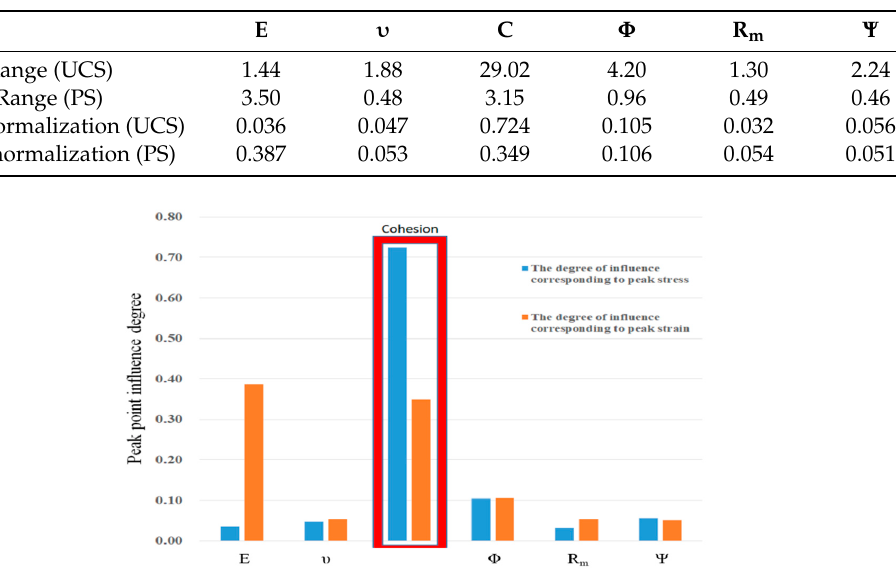
Figure 16. Histogram of the influence of mechanical parameters on peak stress and strain.